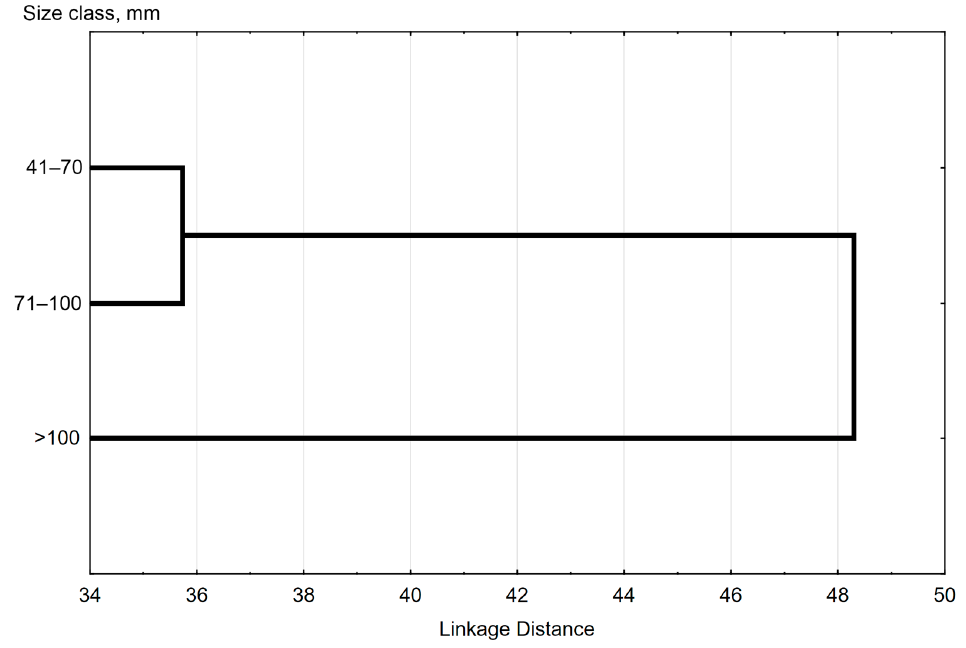
Figure 9. Tree diagram (Euclidean distances) showing differences in the diet composition of ribbed sculpin Triglops pingelii size groups in the Kara Sea, September 2019.